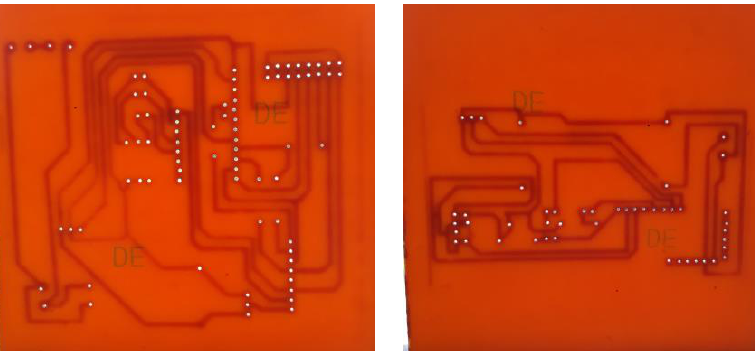
Figure 14. Results for PCBs of 20 × 20 cm.